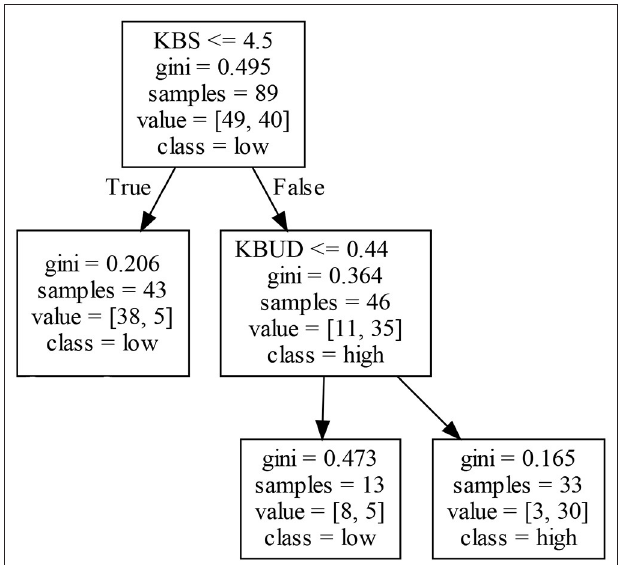
FIGURE 4 | Decision tree for exploitative innovation performance (EIP2) in Cluster I.